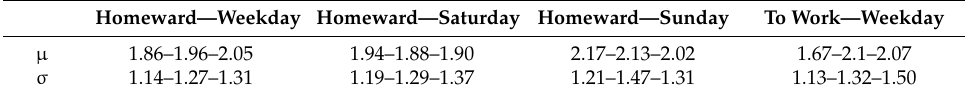
Table A4. Mean ( µ ) and standard deviation ( σ ) of the log-normal distribution of covered distances per trip derived from statistical data (Table A3) [66], depending on the EV user group, weekday and grid region